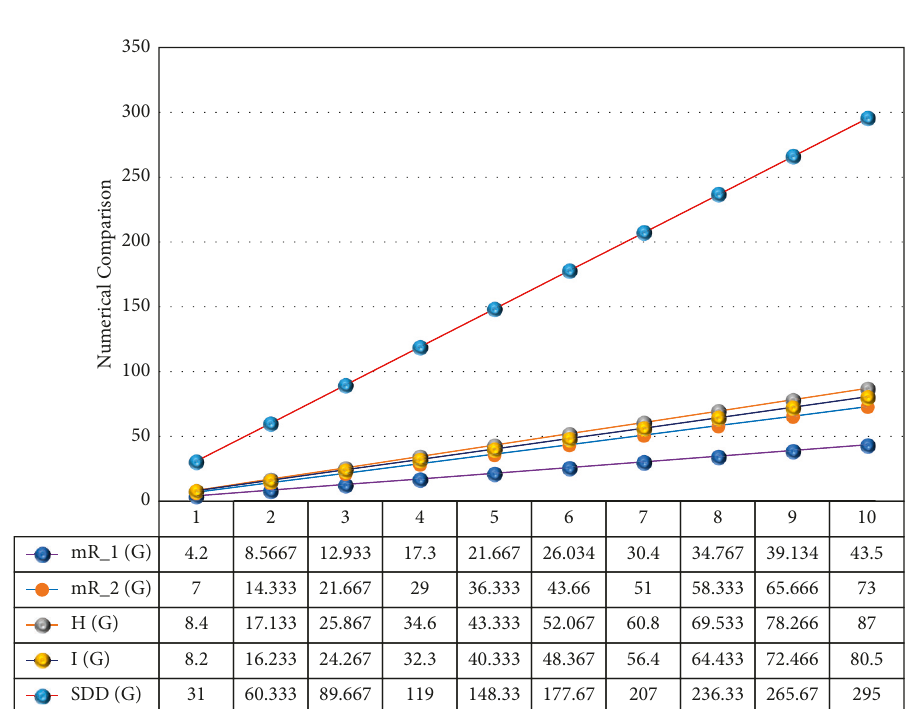
Figure 3: Comparison of m R